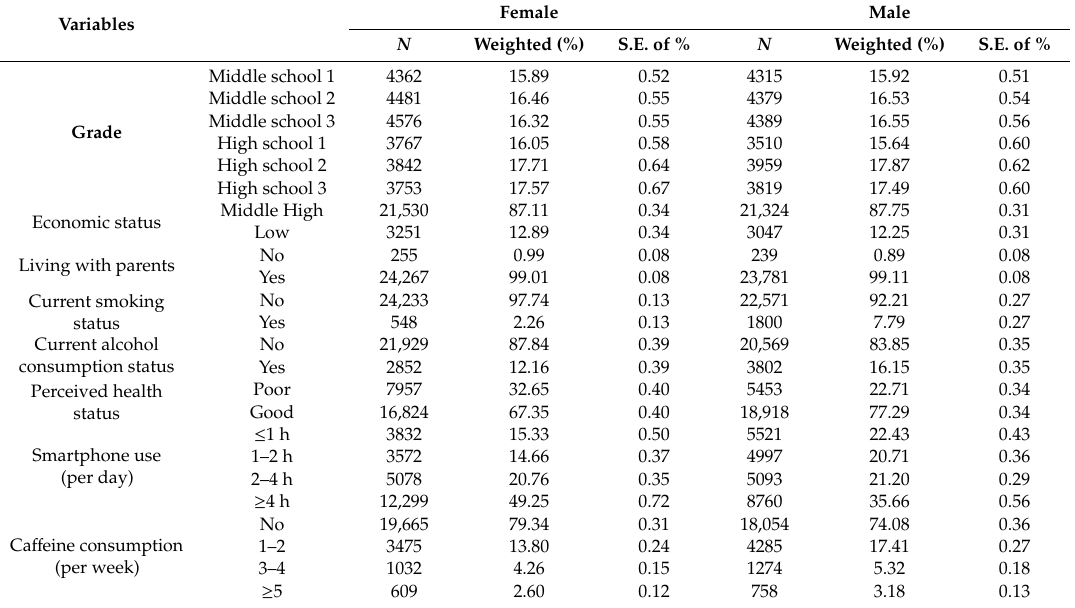
Table 1. General characteristics.